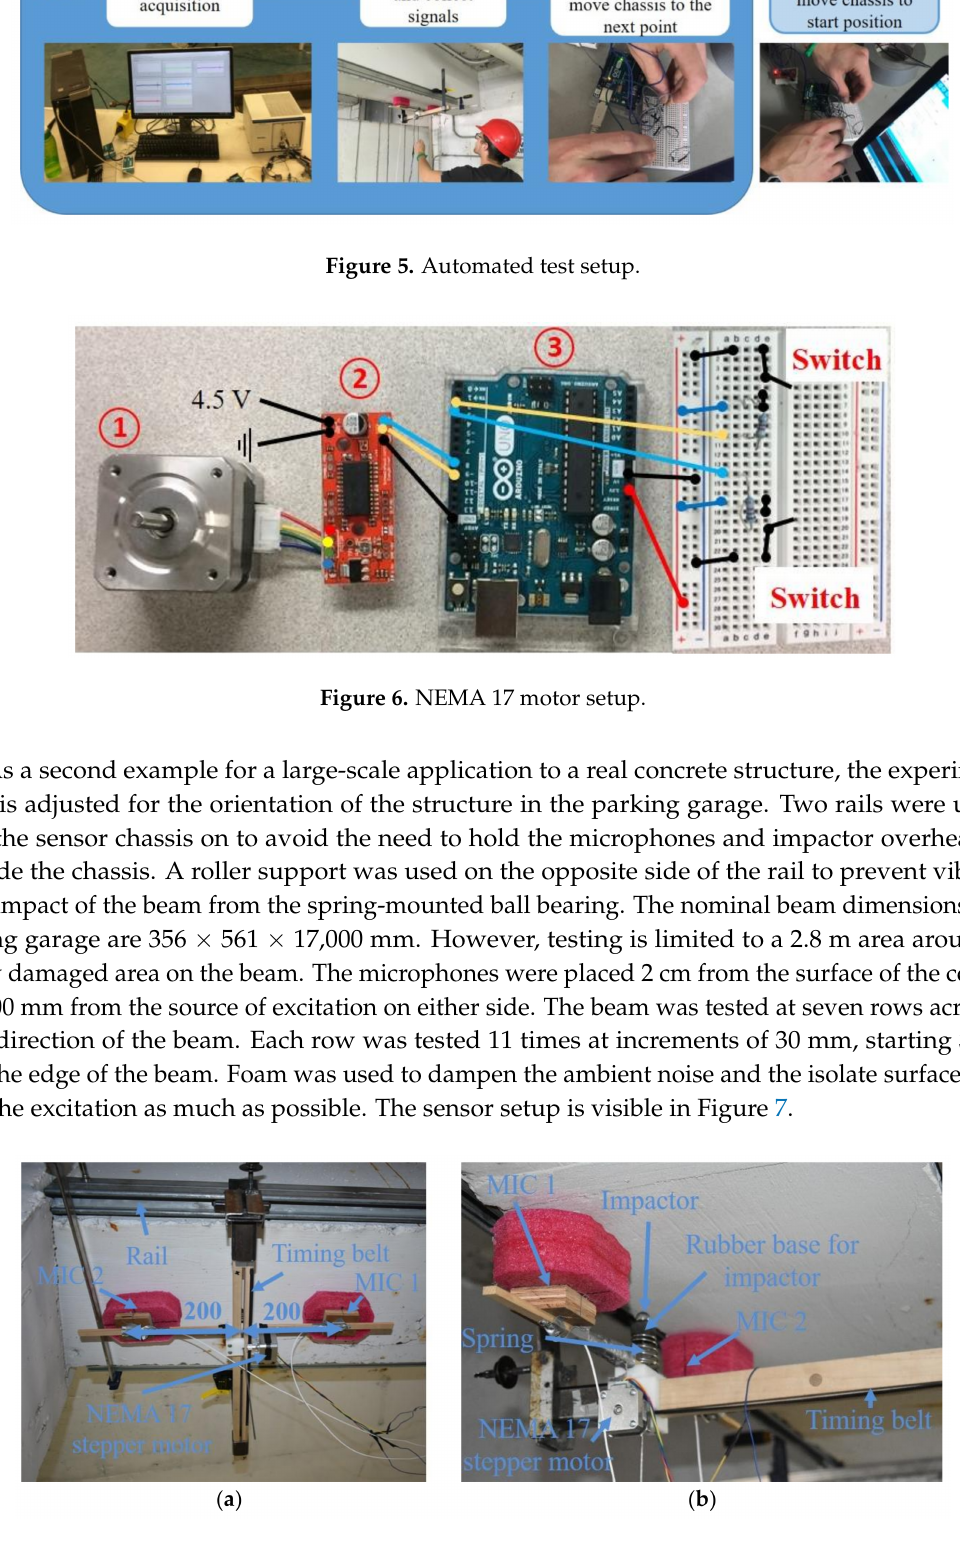
Figure 7. Parking garage test setup ( a ) bottom view ( b ) side